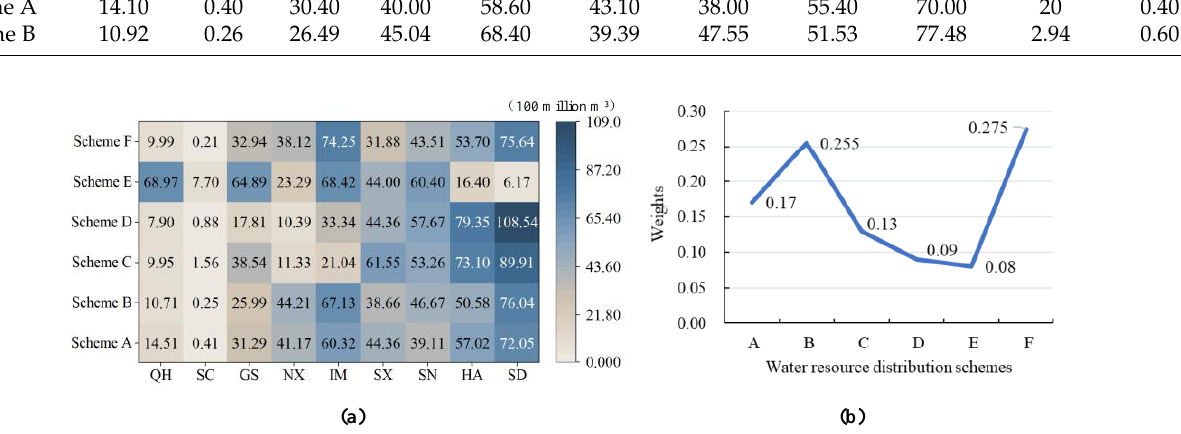
Figure 6. ( a ) Water distributions of the six water distribution schemes. ( b ) The weights of the six water distribution schemes.